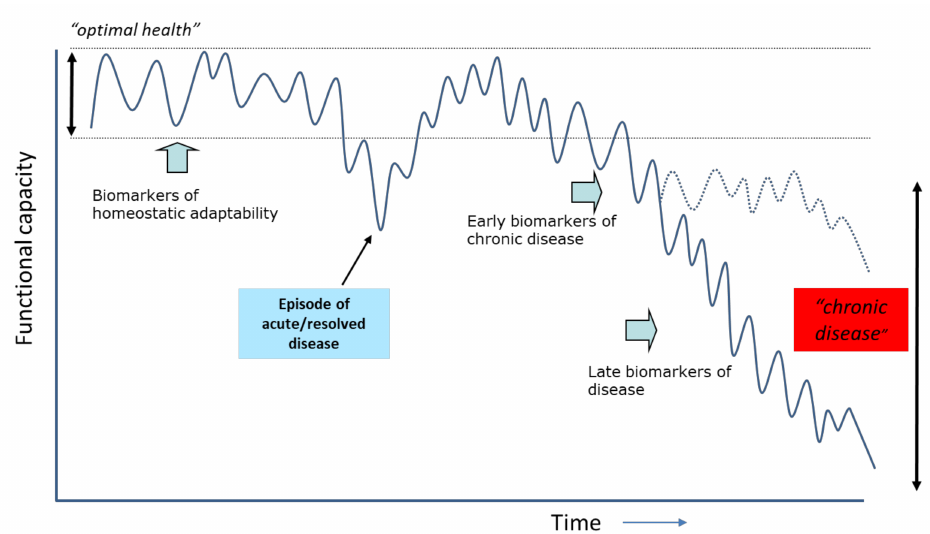
Figure 2. Schematic representation of the concept of homeostasis and loss of health as a function of time. Organisms maintain homeostasis as long as possible by dynamic responses of health mechanisms. Chronic disease is seen as loss of equilibrium. A disease process can either further deteriorate or stabilize at a new homeostatic